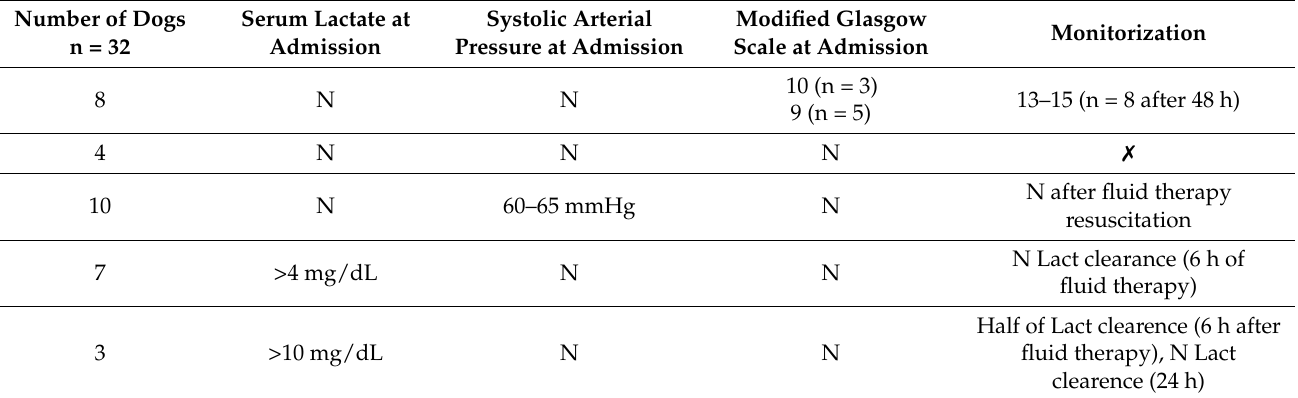
Table 6. Monitorization of lactate, systolic arterial pressure, and modified Glasgow scale in TSG dogs. Number of Dogs Serum Lactate n = 32